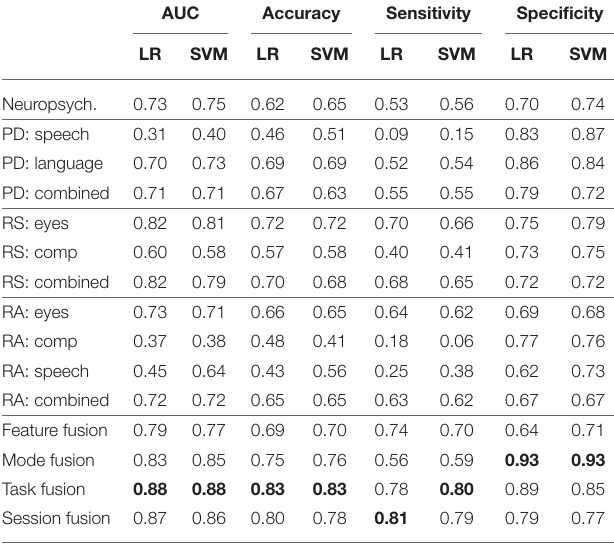
TABLE 6 | Classification results for the baseline classifier trained on neuropsychological test scores, followed by the results at each level of the cascaded classifier.